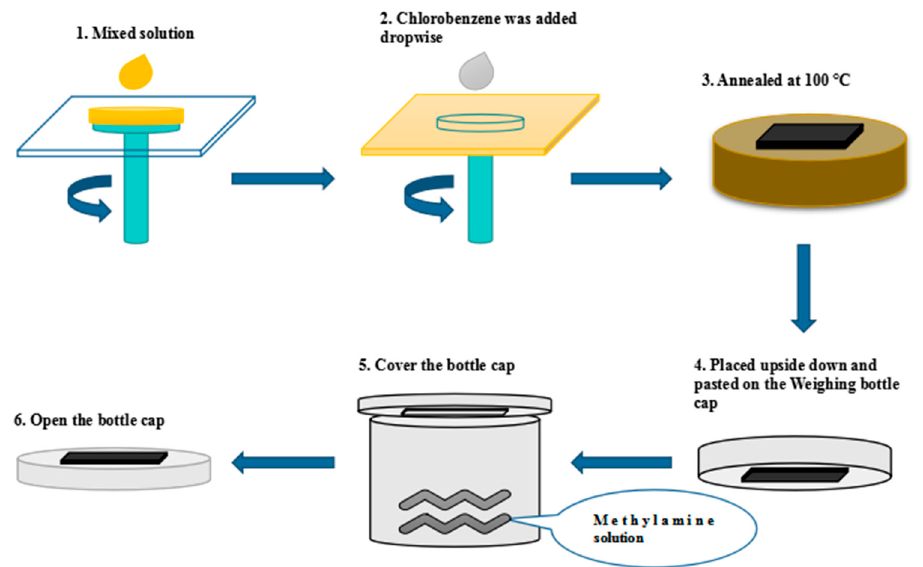
Figure 4. The schematic drawing illustrates the process to prepare MAPbI 3 polycrystalline film and the setup to vapor treatment process. the setup to vapor treatment